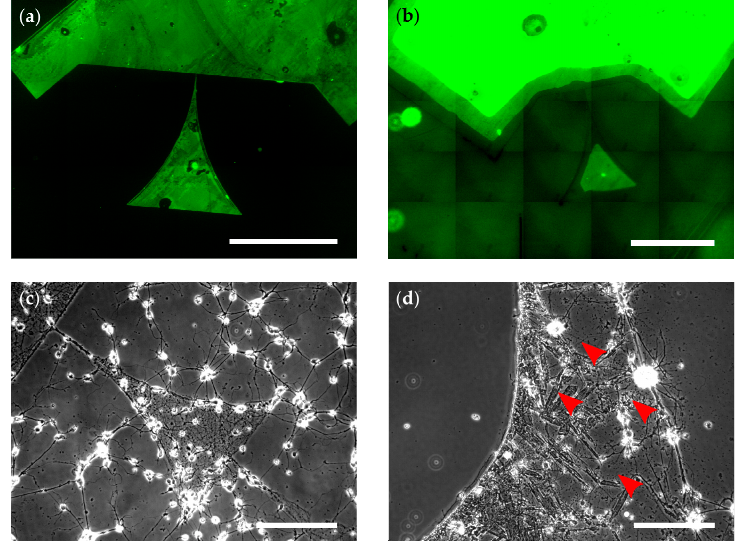
Figure 2. Patterning on untreated glass and with deposition of MnO 2 (compare Figure 1c). ( a , b ) Fluorescence micrographs of microcontact printed, patterned PLL-FITC (poly-L-lysin-fluorescein isothiocyanate) (green) on untreated glass ( a ; scale bar: 400 µ m) or glass with a background of MnO 2 ( b ; scale bar 500 µ m). ( c , d ) Phase contrast micrographs of neurons growing within patterns on untreated glass ( c ; DIV 6) or glass with a background of MnO 2 ( d ; DIV 7). Scale bars: 100 µ m. ( d ) Red arrowheads indicate abnormal neurites.